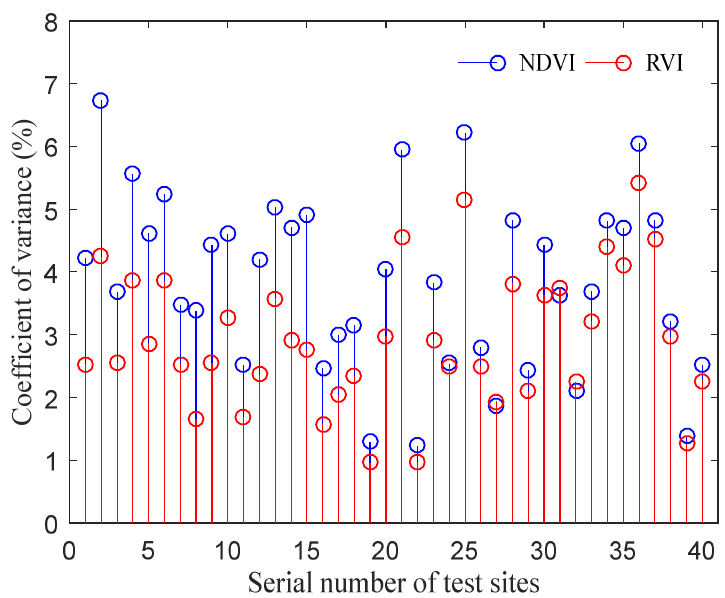
Figure 16. The coefficient of variation (CV) of the statistical results for Normalized Difference Figure 16. The coe ffi cient of variation (CV) of the statistical results for Normalized Di ff erence Vegetation Vegetation Index (NDVI) and Ratio Vegetation Index (RVI) in each test point. Index (NDVI) and Ratio Vegetation Index (RVI) in each test point.